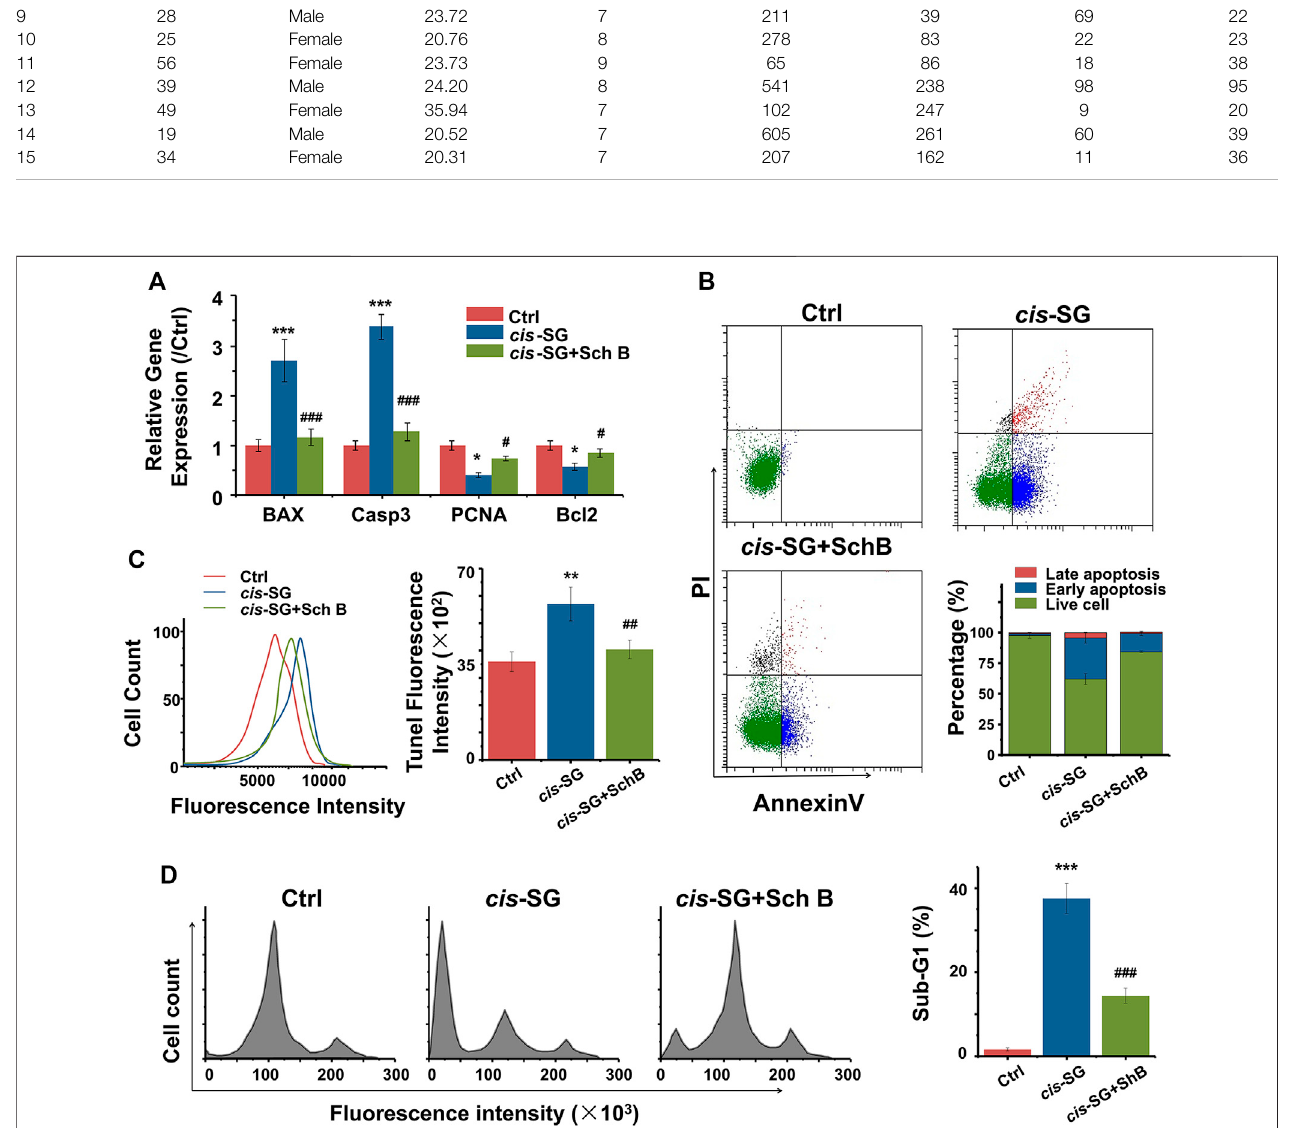
Frontiers in Pharmacology |